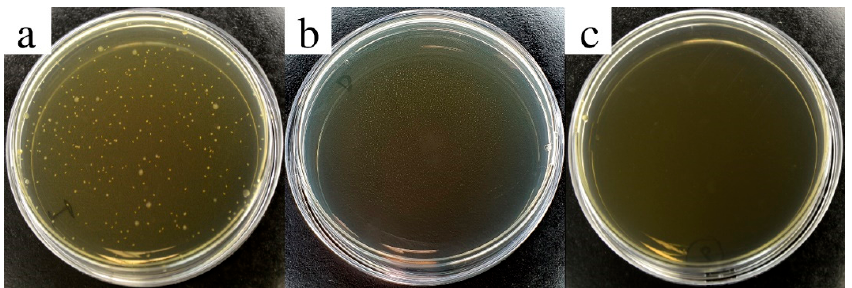
bacterial solution ( a ) and in PPy NP concentrations of 2.0 wt.% ( b ) and 3.5 wt.% ( c